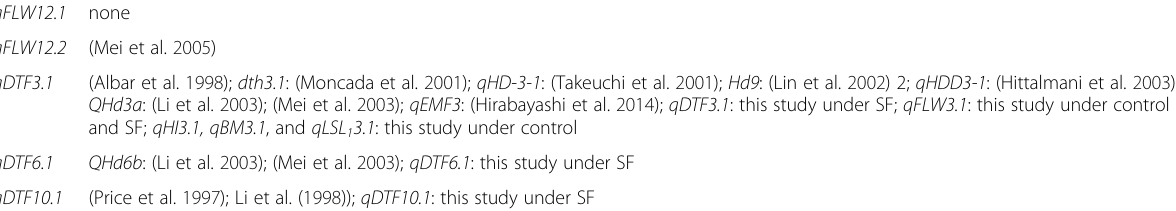
Table 6 Genomic positions of QTLs identified in control irrigated condition with its QTL cluster and comparison to the QTLs identified in stagnant flooding in this study and previously published QTLs (Continued) qFLW12.1